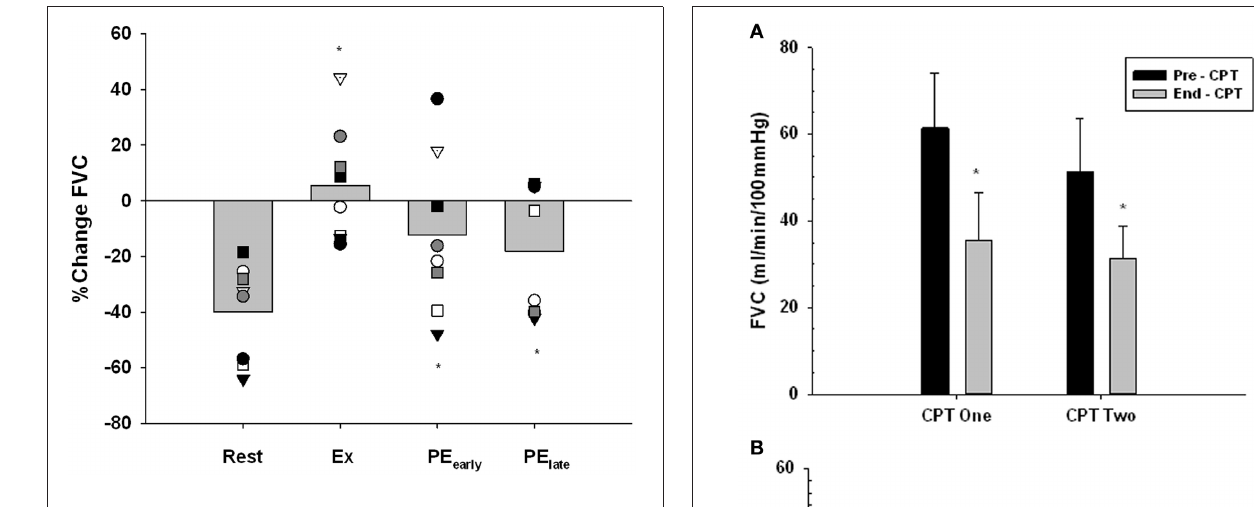
FIGURE 6 | Percent change in forearm vascular conductance (FVC) in response to CPT. The response of each subject is identified with a unique symbol. ∗ indicates significantly different from Rest, P < 0 . 05.